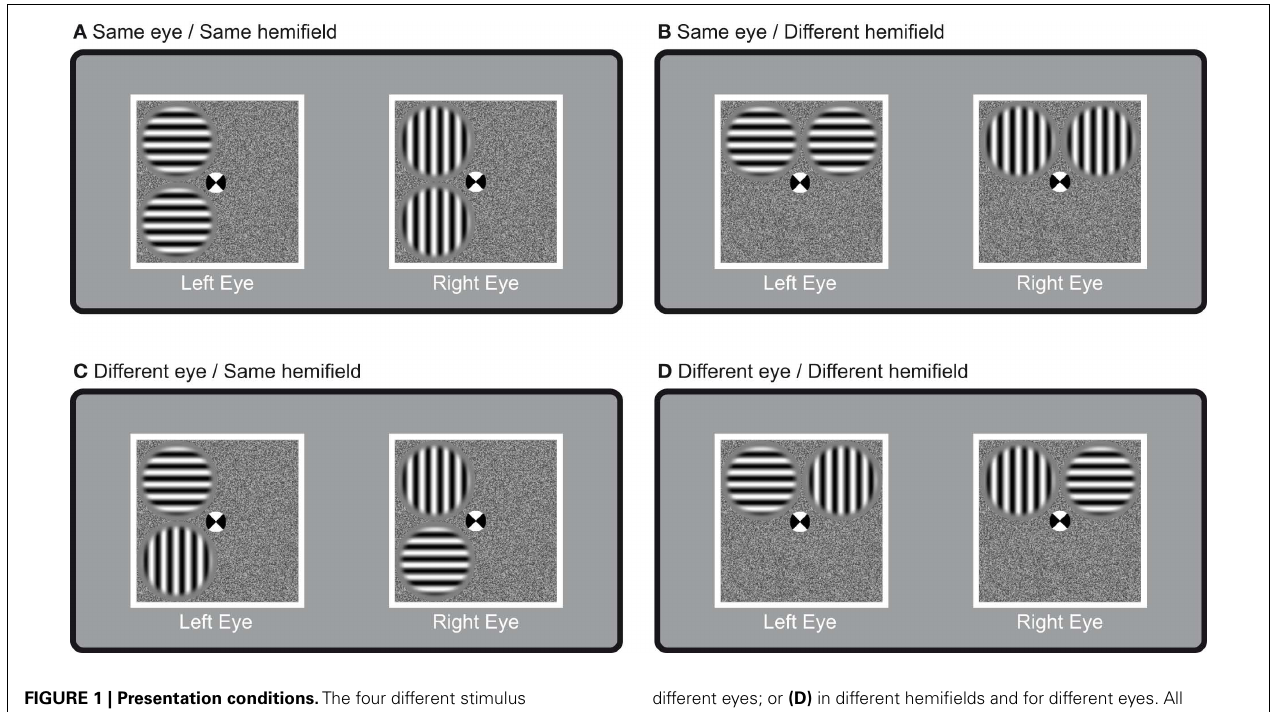
FIGURE 1 | Presentation conditions. The four different stimulus arrangements used.The rival targets were presented such that identical targets were presented (A) in the same hemifield for the same eye; (B) in different hemifields for the same eye; (C) in the same hemifield but for